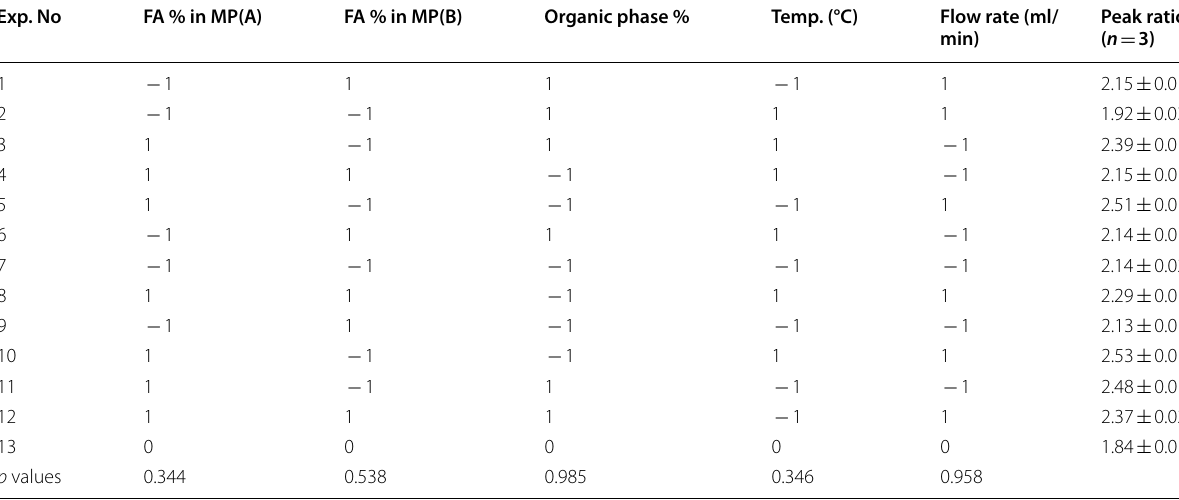
Table 2 The experimental design and results for robustness study Exp. No